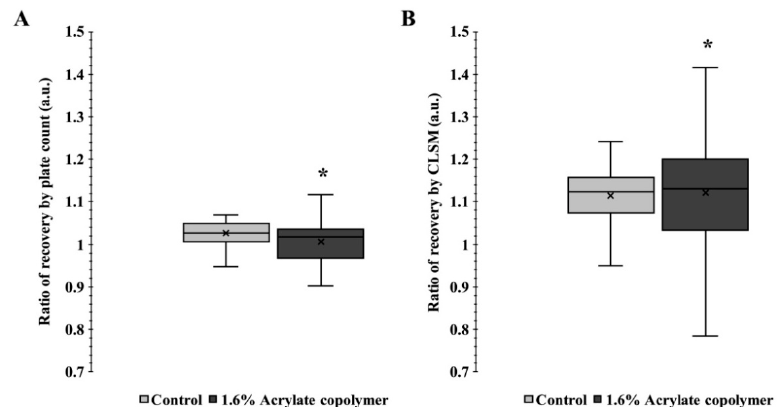
Figure 3. Ratio of bacterial recovery obtained with ( A ) 0% or 1.6% acrylate copolymer by plate count and ( B ) by CLSM enumeration from 3375 images. a.u.: arbitrary unit, *: significantly different from the control ( p -value < 0.05) and ×: mean.